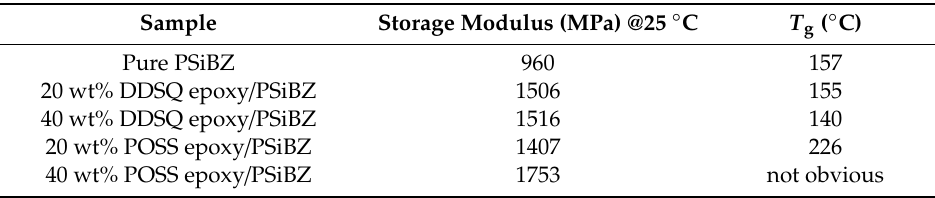
Figure 4. ( a ) Storage modulus and ( b ) tan δ of DDSQ epoxy/PSiBZ nanocomposites as functions of temperature. ( c ) Storage modulus and ( d ) tan δ of the POSS epoxy / PSiBZ nanocomposites as functions temperature. ( c ) Storage modulus and ( d ) tan δ of the POSS epoxy/PSiBZ nanocomposites as functions of temperature. of temperature. Table 3. Storage modulus and tan δ of DDSQ epoxy / PSiBZ and POSS epoxy / PSiBZ nanocomposites. Table 3. Storage modulus and tan δ of DDSQ epoxy/PSiBZ and POSS epoxy/PSiBZ nanocomposites. Sample